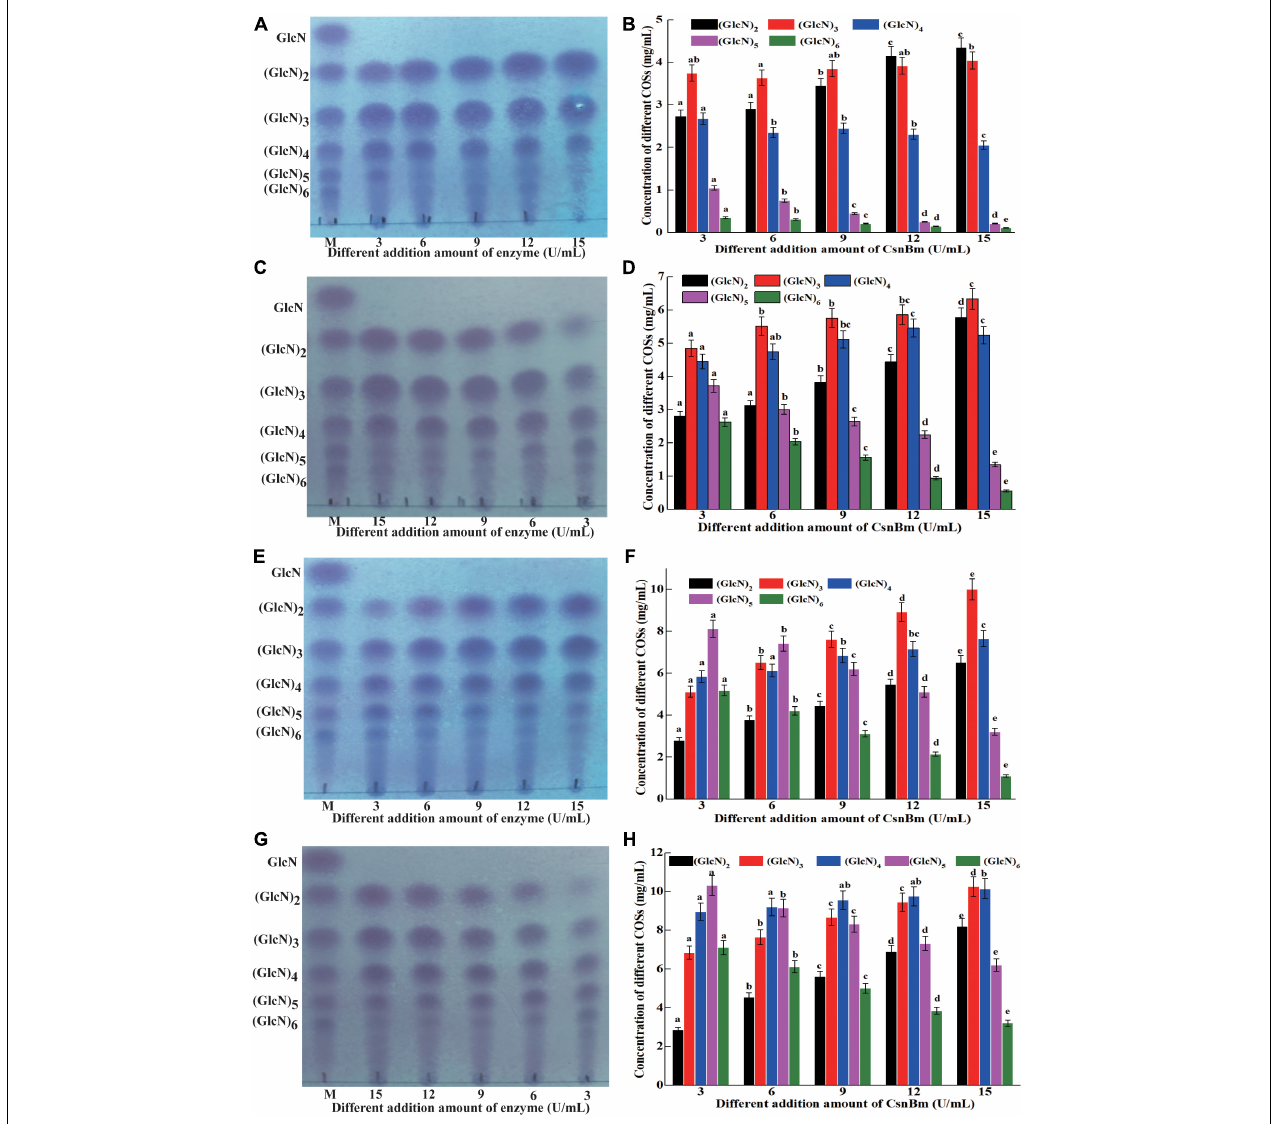
FIGURE 5 | Analysis of hydrolysates from different concentration of colloidal chitosan addition with different amounts of CsnBm. TLC analysis of hydrolysates from 1% (A) , 2% (C) , 3% (E) , and 4% colloidal chitosan (G) . M, marker sugars containing GlcN, (GlcN) 2 , (GlcN) 3 , (GlcN) 4 , (GlcN) 5 , and (GlcN) 6 . HPLC analysis of hydrolysates from 1% (B) , 2% (D) , 3% (F) , and 4% colloidal chitosan (H) . The effects of different CsnBm additions on the production of the same COS were analyzed. Different lowercase superscripts in the columns with same color indicated statistical difference ( p < 0.05). Experiments were conducted in triplicate, and measurements were presented with their means and SD. Data were subjected to one-way ANOVA analysis by SPSS (version 24.0) and Duncan’s multiple range tests ( p < 0.05) to compare the mean value of different